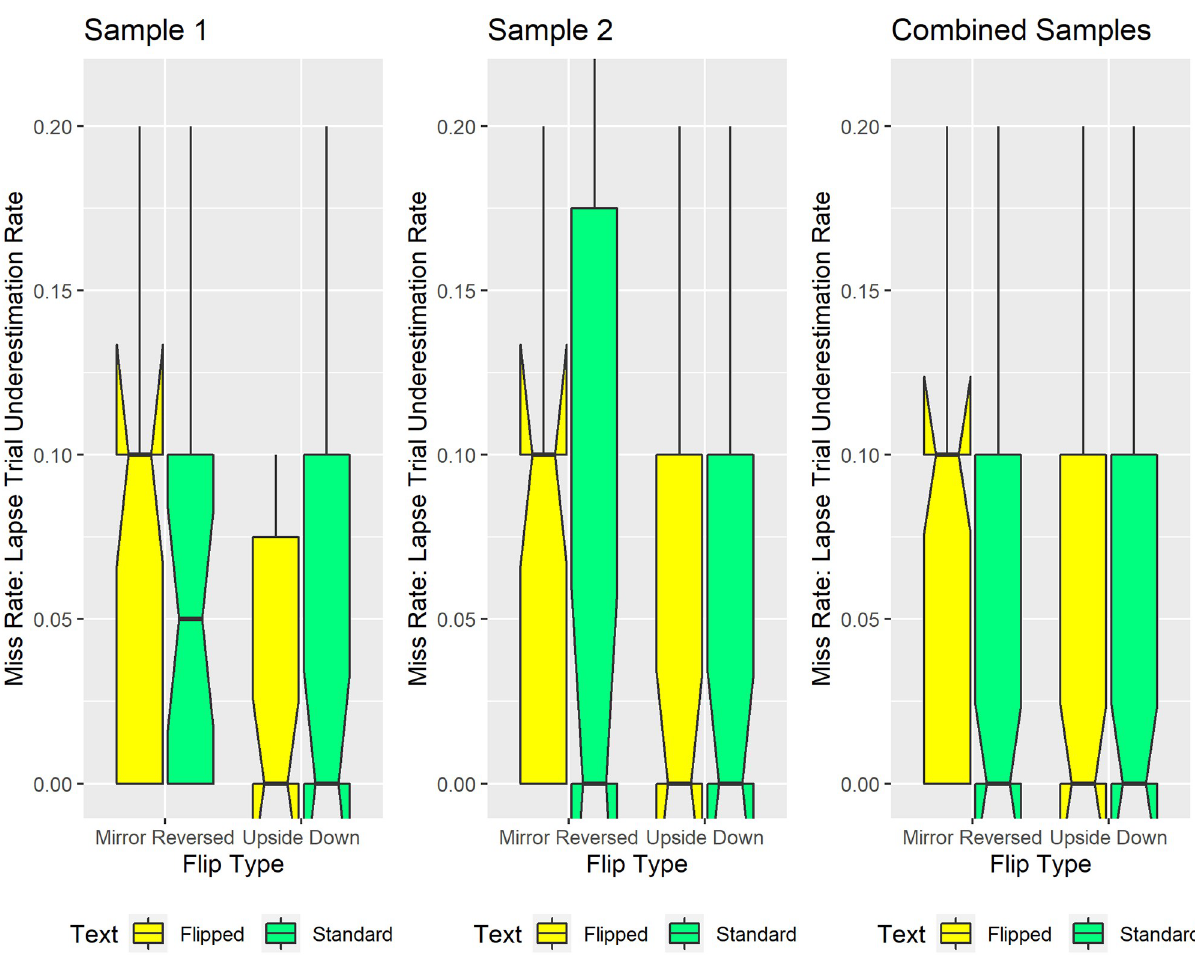
Fig 8. Lapses that reflect sentence length underestimates. The ordinate reflects the proportion of trials when participants underestimated sentence length, incorrectly classifying 23-word or 24-word sentences as having “Fewer-Than-17-Words”. Mirror-reversed text consistently generated more sentence-length underestimates, on median, than did the other conditions. The mirror-reversed text also produced distributions skewed such that the 75th percentile equaled the median. The corresponding box plots show upward-pointing protrusions. Conversely, other experimental conditions produced distributions skewed such that the 25th percentile equaled the median. Those conditions show downward-pointing protrusions. Conventions remain the same as in Fig 5.